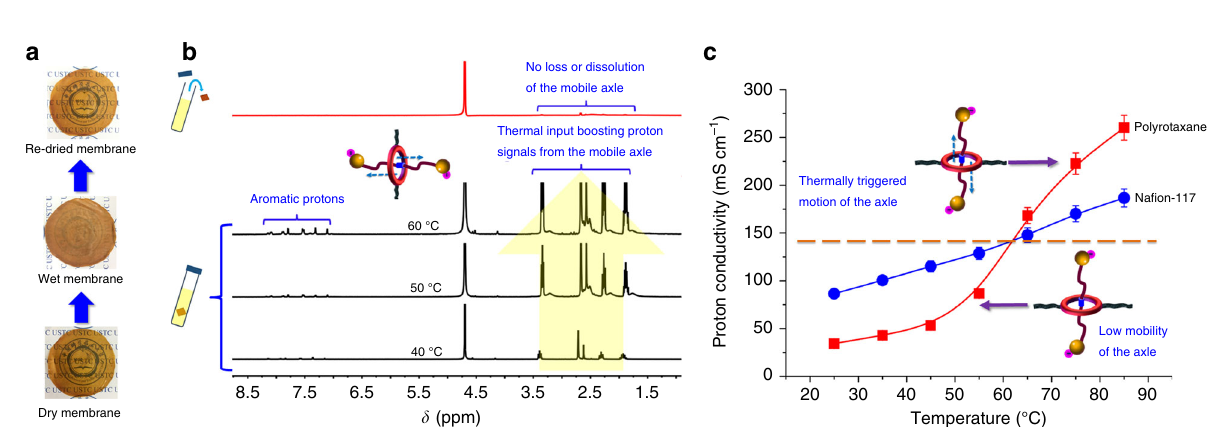
a Grafting ratio, calculated from the content of the sulfonated axles and crown ether moieties based on the elemental analysis results b λ , Water content ratio, a molar ratio of water molecules to the sulfonated axles, calculated from WU and IEC c TS, tensile strength measured in the stress – strain curve; Eb, elongation at break